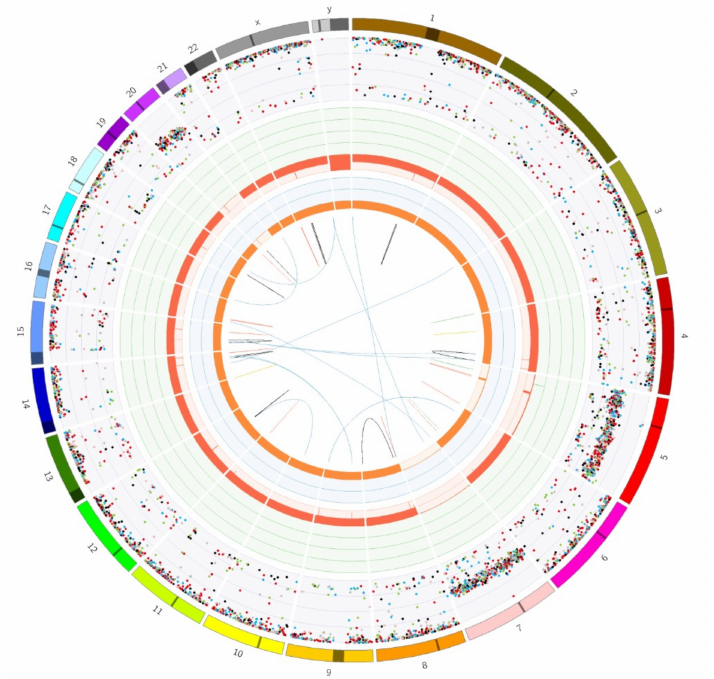
Figure 2. Circos plot showing a near-homozygous genome in HCC was detected by whole genome sequencing performed on biopsy material obtained from a metastatic hepatic lesion in the presented male patient case. LOH in all autosomes except for 5, 7, and 20. The outer first circle shows all chromosomes and the second circle shows all somatic variants (allele frequencies have been corrected for tumor purity and scale from 0% to 100%). The fourth circle represents the observed ‘minor allele copy numbers’ across the chromosome. The range of the chart is from 0 to 3 and the expected normal minor allele copy number is 1. Anything below 1 is shown as a loss (depicted in orange) and represents an LOH